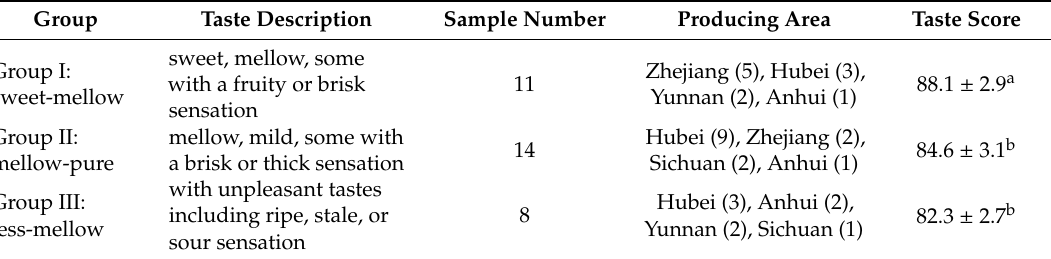
Table 1. Characteristics of the thirty-three congou black tea samples enrolled in this study, including their production areas, taste characteristics, and the overall taste scores evaluated by human panelists. Group